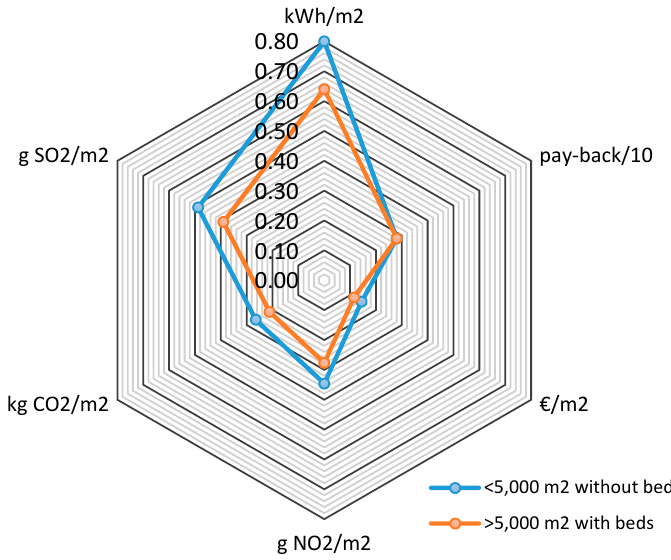
Figure 3. Potential of energy saving derived from DWH installations.